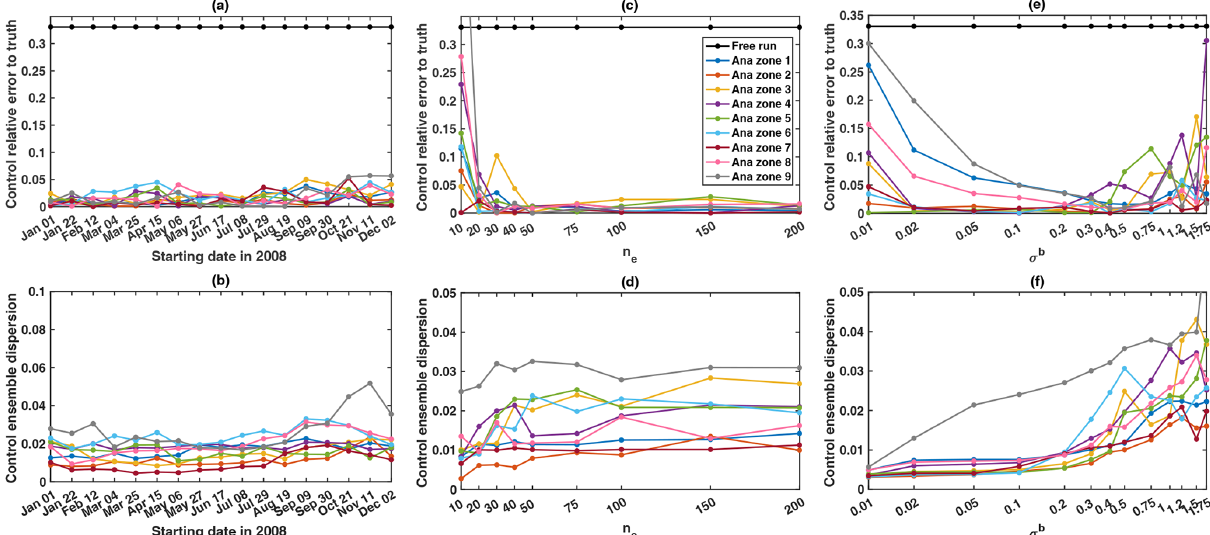
Figure C1. Top: relative error (to the truth) and (bottom) dispersion of the analysis control ensemble for each zone for the sensitivity tests to (a, b) the data assimilation starting date, (c, d) the ensemble size n e , and (e, f) the background error standard deviation σ b . For each test, a set of one-cycle long data assimilation experiments is run. Top only: the relative errors in zone 1 (dark blue line), zone 2 (orange line), zone 3 (yellow line), zone 4 (purple line), zone 5 (green line), zone 6 (light blue line), zone 7 (burgundy red line), zone 8 (pink line) and zone 9 (gray line) are compared to the basin-averaged openloop relative error (black